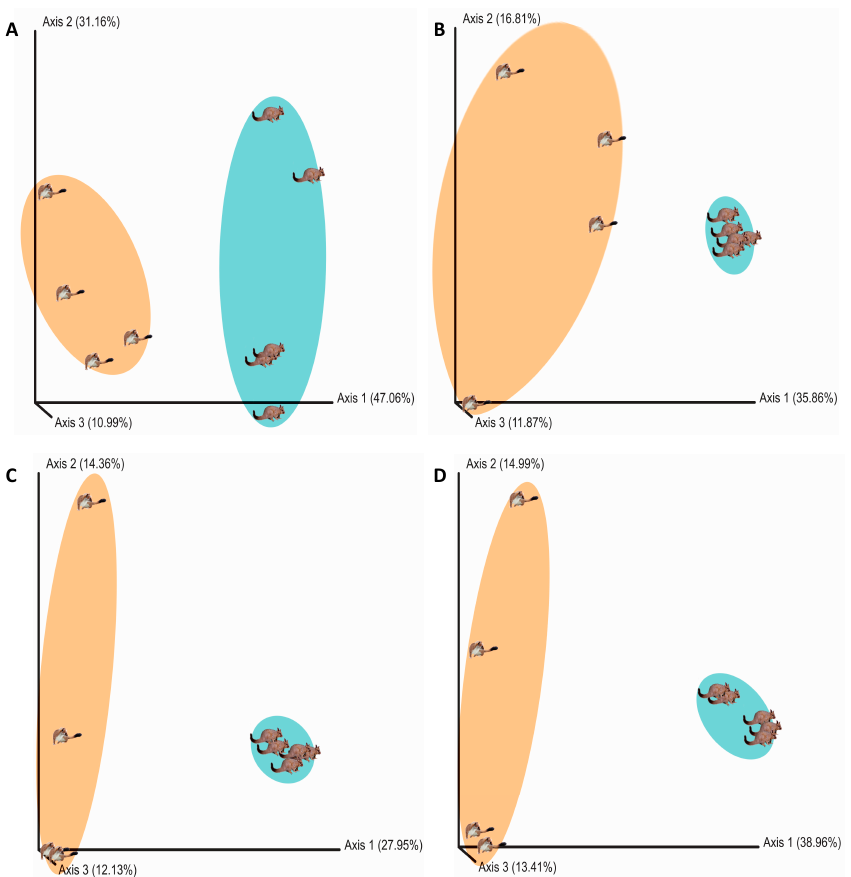
Figure 1. Component analyses of different α and β diversity indices in the oral microbiota of brushtail possums and stoats. ( A ) Weighted Unifrac, ( B ) unweighted Unifrac, ( C ) Jaccard’s index, and ( D ) Bray Curtis. For each axis, the percentage of variance explained by that axis is indicated. brushtail possums (turquois) and stoats(orange).